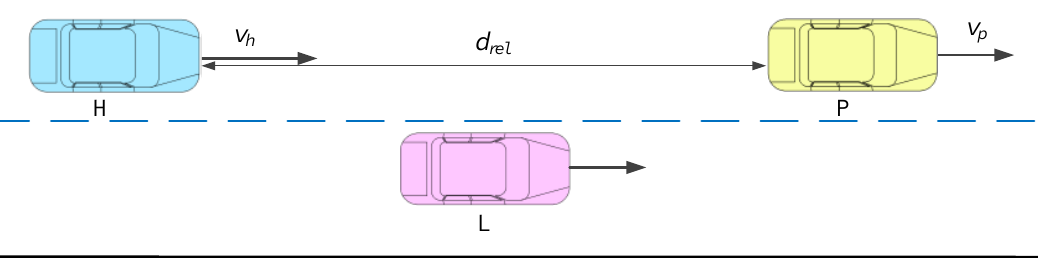
Figure 11. Sufficient relative distance.